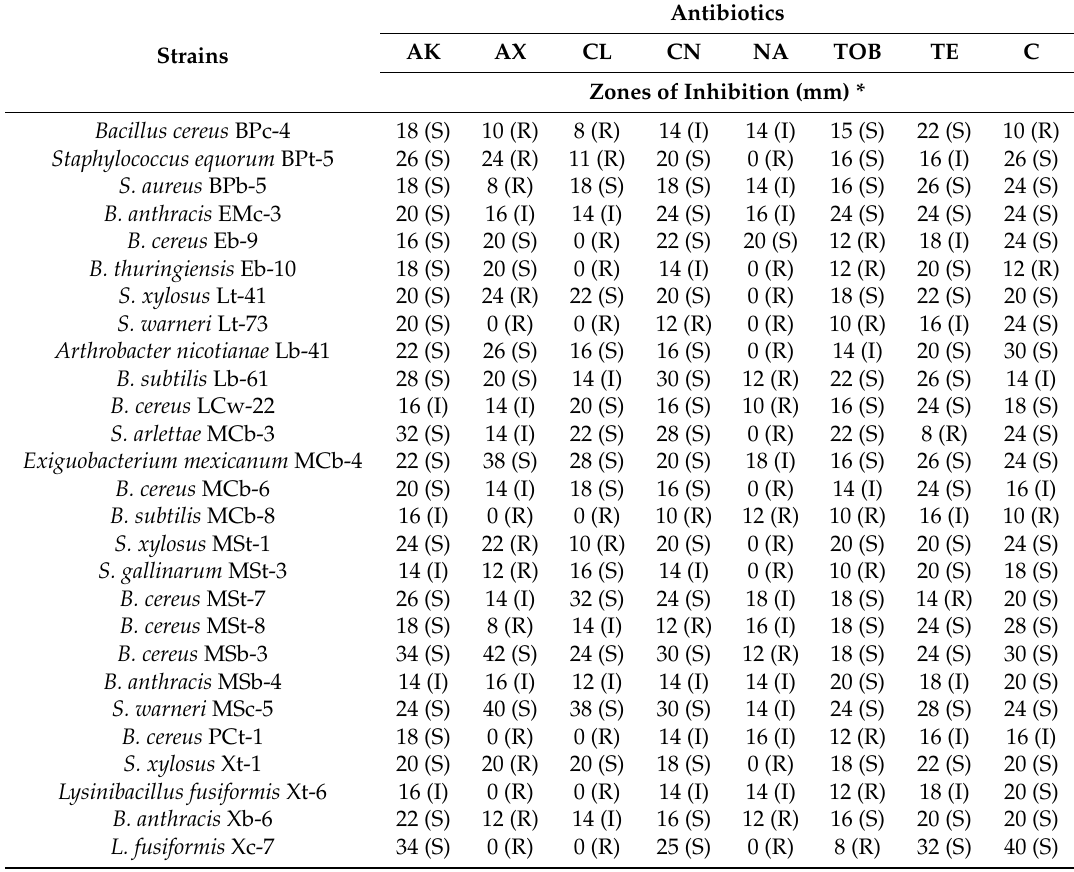
Table 4. Antibiotic susceptibility pattern of different Gram-positive bacterial isolates. For analysis, three set of plates for each strain or antibiotic were incubated at 37 ◦ C for 24 h.